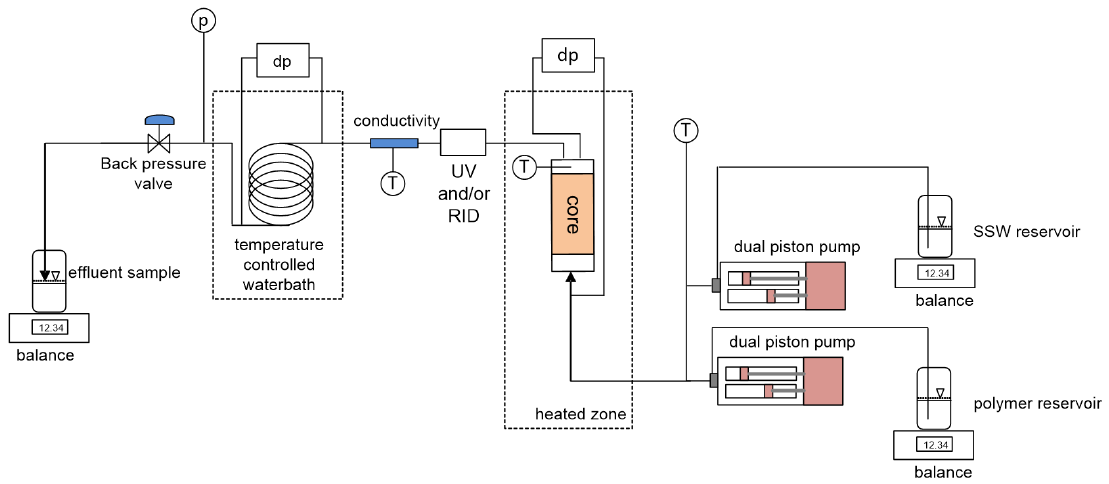
Figure 3. Schematic of the setup of the core flooding experiments.